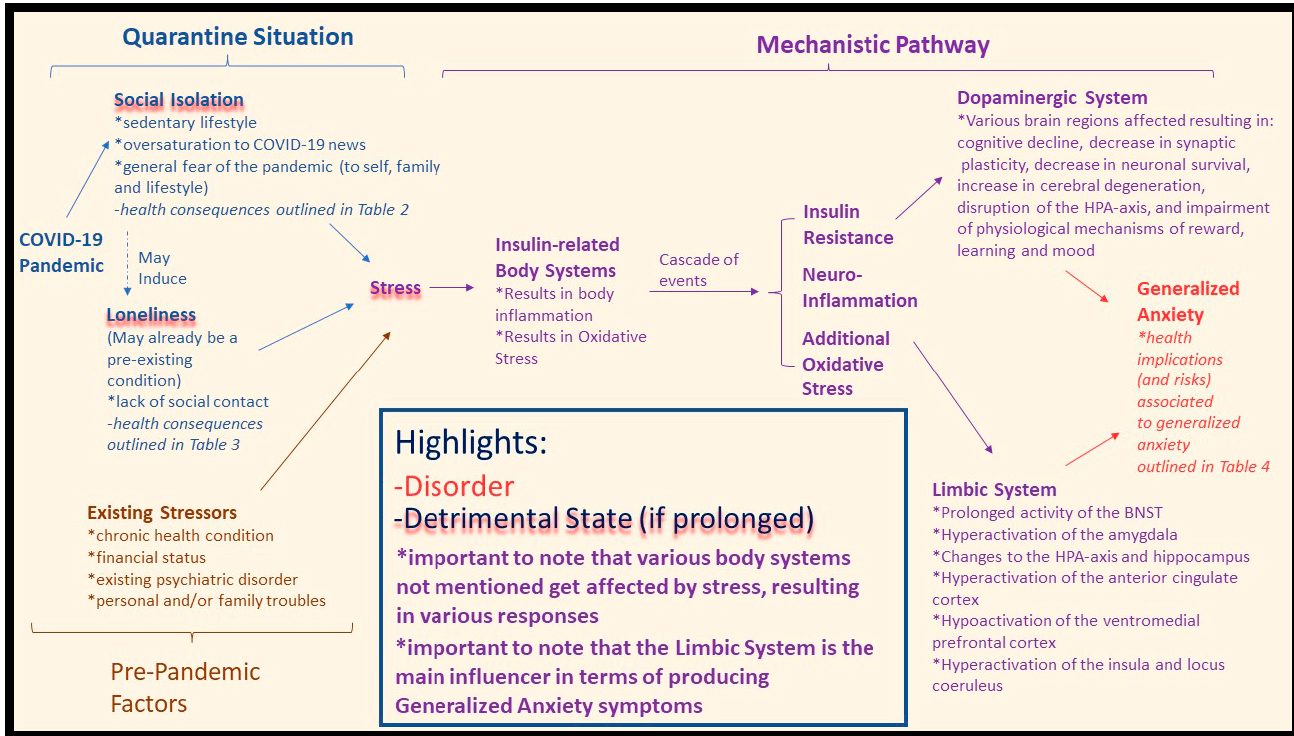
Figure 1. General proposed pathway influenced by various factors. Physiological concepts are applied to formulate the pathway. The proposed mechanism where the COVID-19 pandemic has caused quarantine response: social isolation conditions have a number of health issues associated with stress (highlighted in blue). Loneliness may be induced by social isolation, or make an existing loneliness condition worse, and is also associated with stress (highlighted in blue). Pre-pandemic factors also play a role (highlighted in brown). The resulting stress is associated with a cascade of events (highlighted in purple), ending with a link to generalized anxiety.